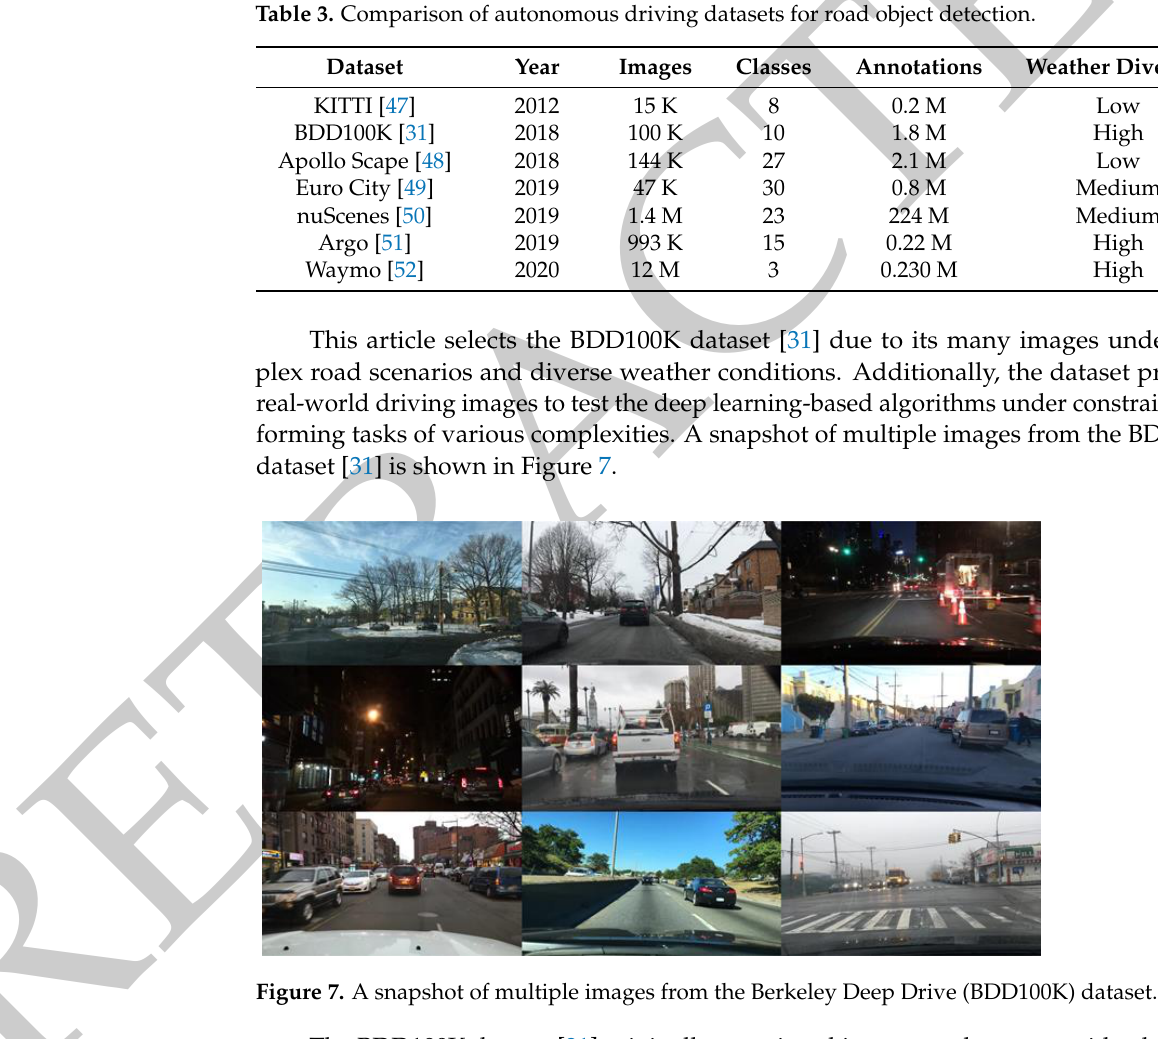
Table 4. The number of annotated objects in the Berkeley Deep Drive (BDD100K) dataset. Set